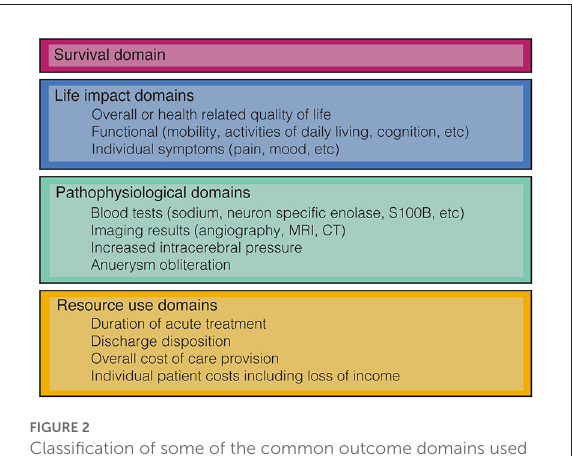
FIGURE2 Classification of some of the common outcome domains used in aSAH research based on the OMERACT filter 2.0